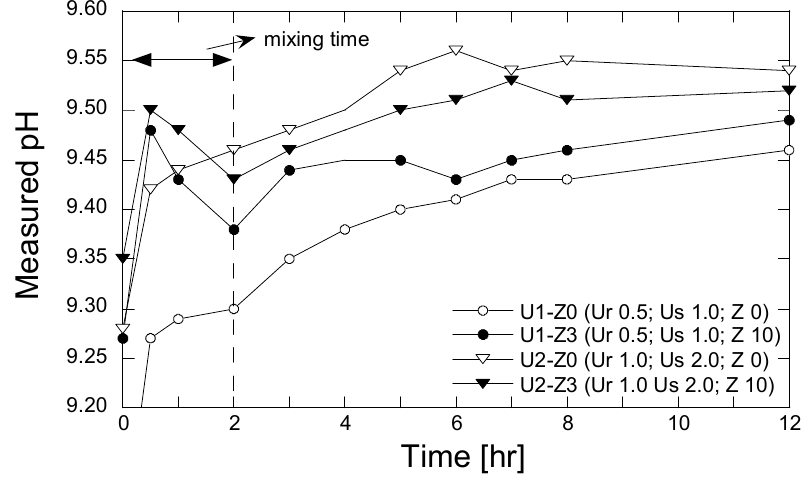
Figure 8. Evolution of pH with time.